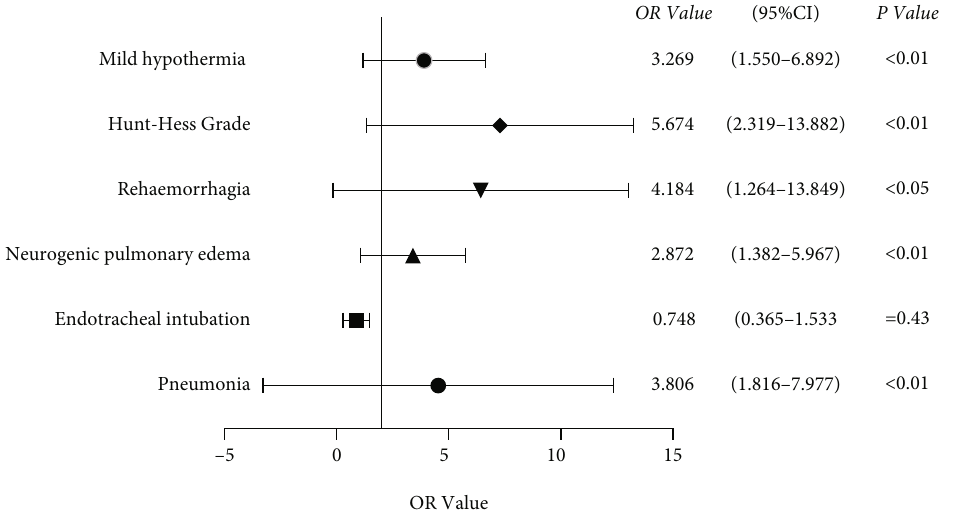
Figure 3: Meta-analysis graph based on the binary logistic regression model.